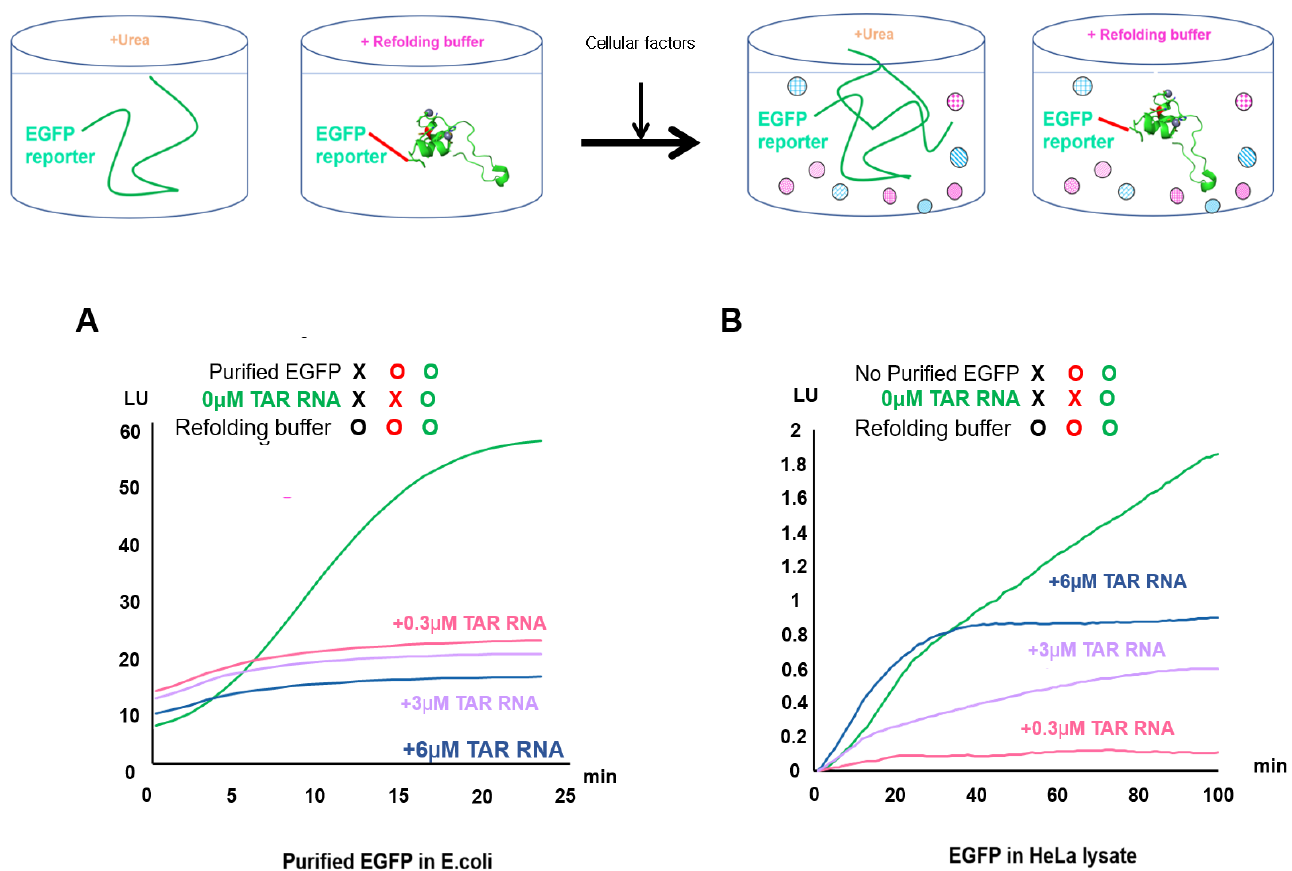
Figure 2. Kinetic refolding of EGFP as a folding reporter under crowded or uncrowded conditions. The effect of refolding at different TAR RNA concentrations on the EGFP (green line) from HeLa lysate and the EGFP (green line) from E. coli was analyzed. ( A ) The EGFP intensity of refolding in uncrowded conditions was measured from EGFP refolding at specific concentrations (0.3, 3, and 6 µ M) of TAR RNA for 25 min ( E. coli ), with a refolding time of 10 min. ( B ) The effects of uncrowded conditions compared with the effects of crowded conditions on the GFP intensity were measured based on EGFP refolding at specific concentrations (0.3, 3, and 6 µ M) of TAR RNA for 80 min (HeLa lysate), with a refolding time of 40 min. The fluorescence intensity of the EGFP emission is given in relative light units (LU).